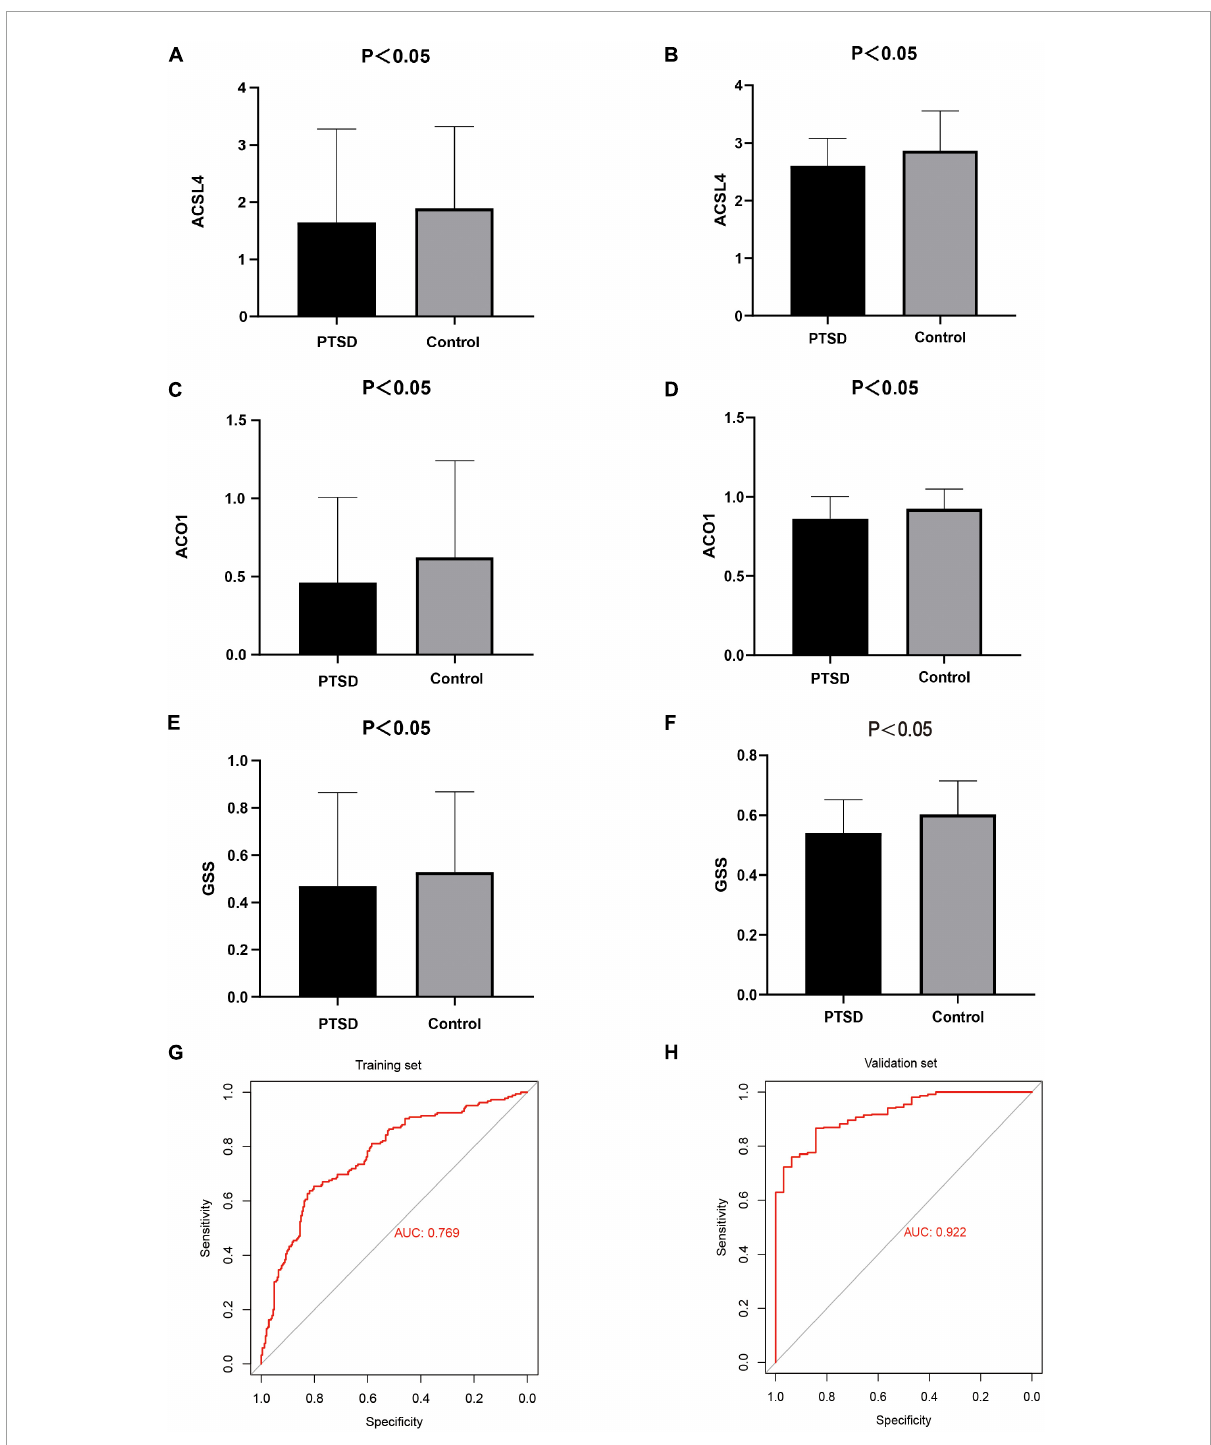
FIGURE11 (A,B) t -Tests found that ACSL4 was down-expressed in the training datasets and the validation datasets. (C,D) ACO1 was down-expressed in the training datasets and the validation datasets. (E,F) GSS was down-expressed in the training datasets and the validation datasets. (G,H) The AUC of ROC curves reached 0.769 and 0.922 in the training datasets and the validation datasets, indicating the LASSO model has good diagnostic